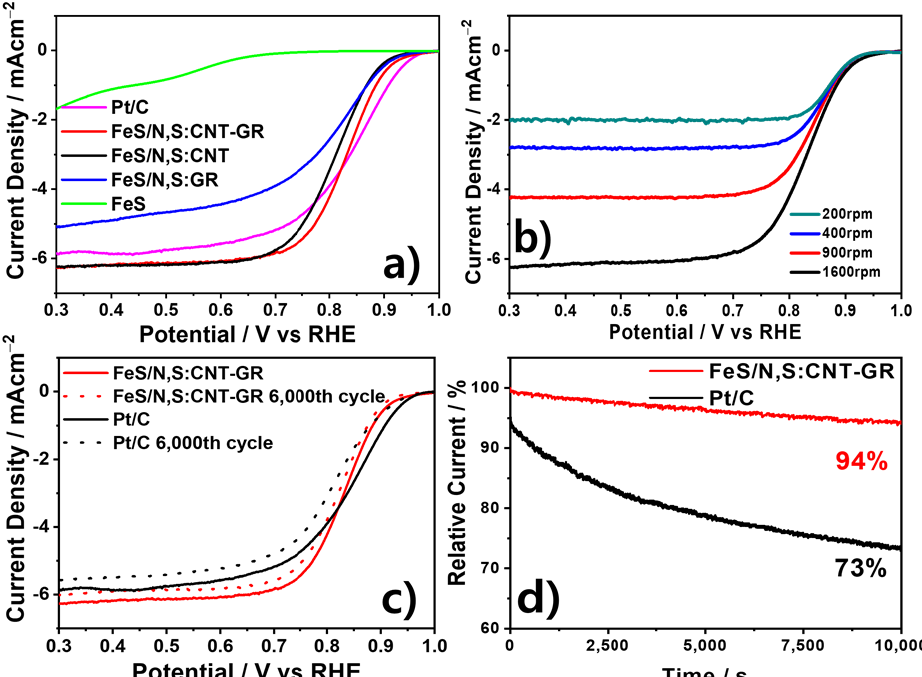
Figure 4. ( a ) LSV curves of prepared FeS catalysts. ( b ) LSV curves of FeS/N,S:CNT–GR at different rotation rates. ( c ) Stability measurements of FeS/N,S:CNT–GR and Pt/C after 6000 repeated potential cycles. ( d ) Chronoamperometric responses of FeS/N,S:CNT–GR and Pt/C at 0.7 V over 10,000 s.